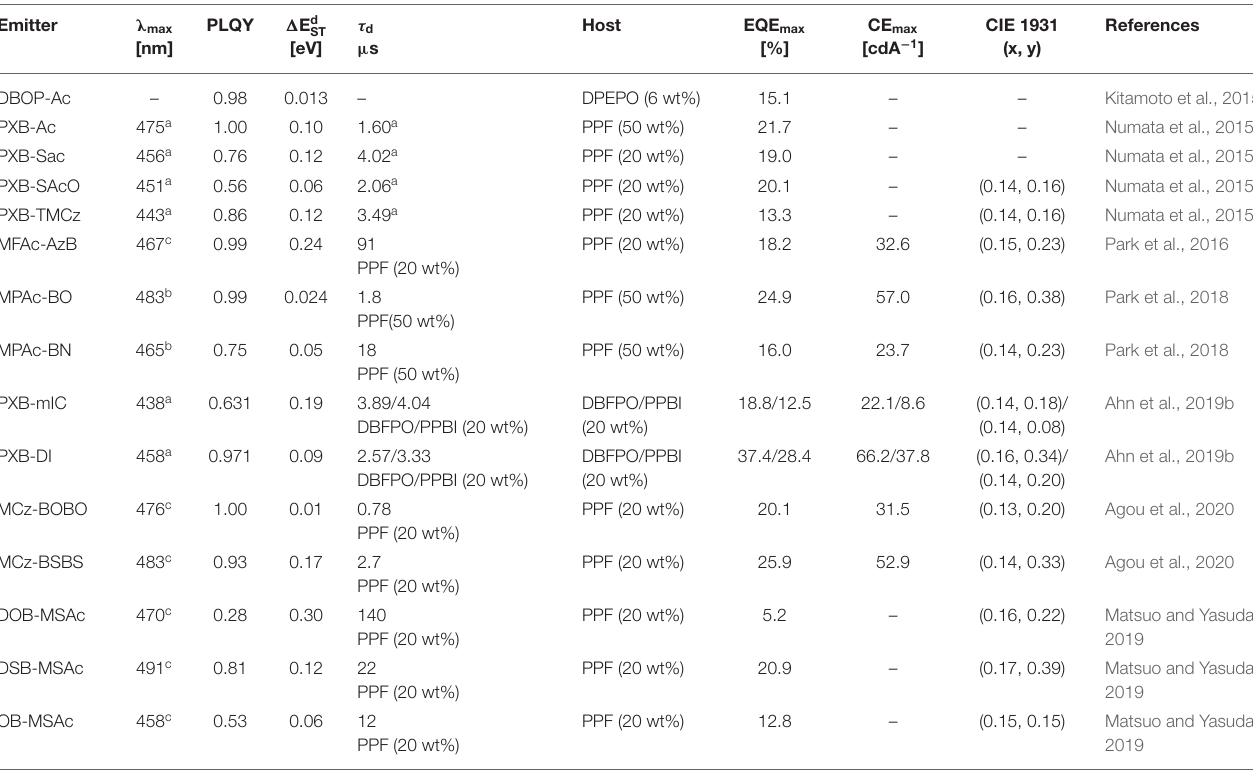
TABLE 2 | Summary of photophysical properties and device performance of the partially bridged boron-based type blue thermally activated delayed fluorescence (TADF) emitters.